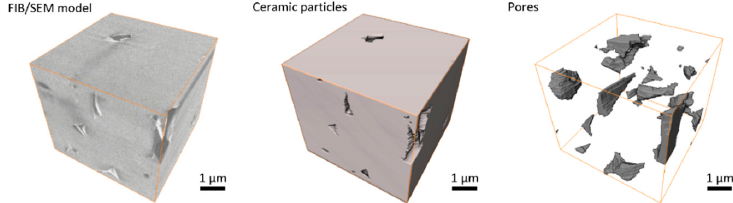
Figure 9. FIB / SEM-based 3D images of Al 2 O 3 sintered ceramic samples, manufactured and processed with stereolithography-based additive technology; there are shown the original FIB / SEM greyscale 3D image and the results of image segmentation: ceramic particles and pores, remaining after